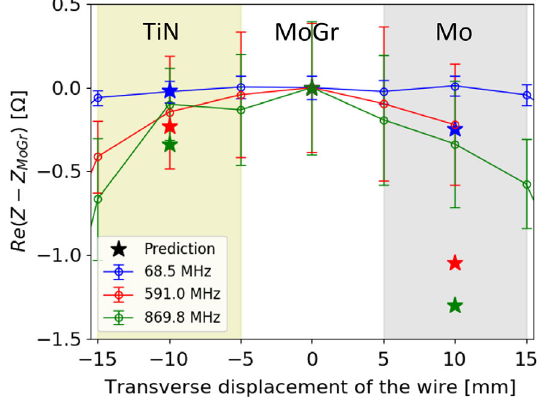
FIG. 7. A resonant wire measurement of the jaw impedance was performed at different locations along the jaw in a test stand prior to the installation of the prototype in LHC [39]. The difference in the real part of the longitudinal impedance with the respect to the uncoated bulk, depicted by lines and error bars, suggests a larger than expected resistivity of the Mo stripe for all tested frequen- cies: 68.5 MHz (blue), 591.0 MHz (red), and 869.8 MHz (green). The expected values are based on numerical simulations with IW2D [33] and shown by stars.